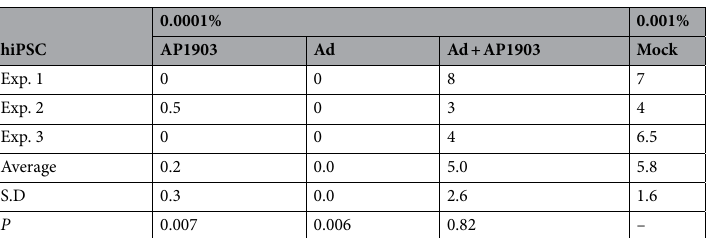
entry of the Ad vector into those cells was comparable. On the other hand, CMV promoter activity is known to be dormant in undifferentiated hiPSCs and upregulated during the differentiation of hiPSCs 14–16 . Therefore, it There are various markers for pluripotent stem cells, including stage-specific embryonic antigen (SSEA)-3, SSEA-4, TRA-1-60, and TRA-1-81, which can be recognized by antibodies 26–30 , and Fucα1–2Galβ1–3GlcNAc (GalNAc)-containing glycans, which can be recognized by rBC2LCN 17,31 . Although flow cytometry analysis can detect residual undifferentiated hiPSCs in differentiated cells, by using pluripotent stem cell markers, its detec- tion limit is reported to be 0.1% 10 . We showed that the proportion of undifferentiated hiPSCs was increased in cells treated with the Ad vector and AP1903 by about 20-fold compared with that in mock-treated cells, when hiPSC-NPC preparations were supplemented with hiPSCs at a concentration of 1%. In addition, when cells were treated with the Ad vector and AP1903, hiPSCs intermingled in hiPSC-NPC preparations at a concentration